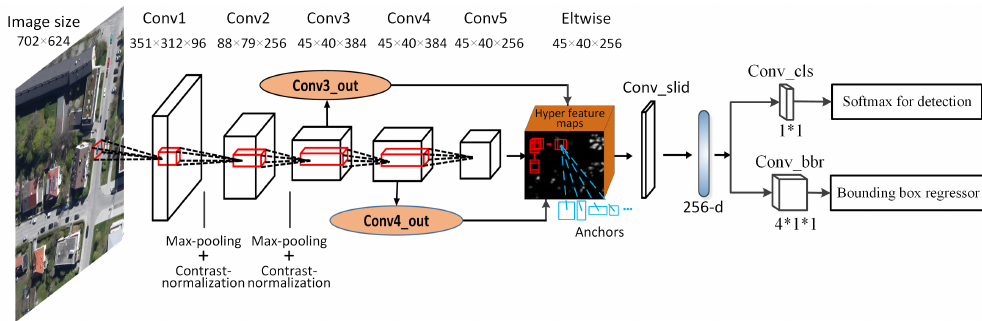
Figure 3. Architecture of Hyper Region Proposal Network (HRPN). For 702 × 624 images, the feature maps size of Conv1-Conv5 are 351 × 312 × 96, 88 × 79 × 256, 45 × 40 × 384, 45 × 40 × 384, 45 × 40 × 256,